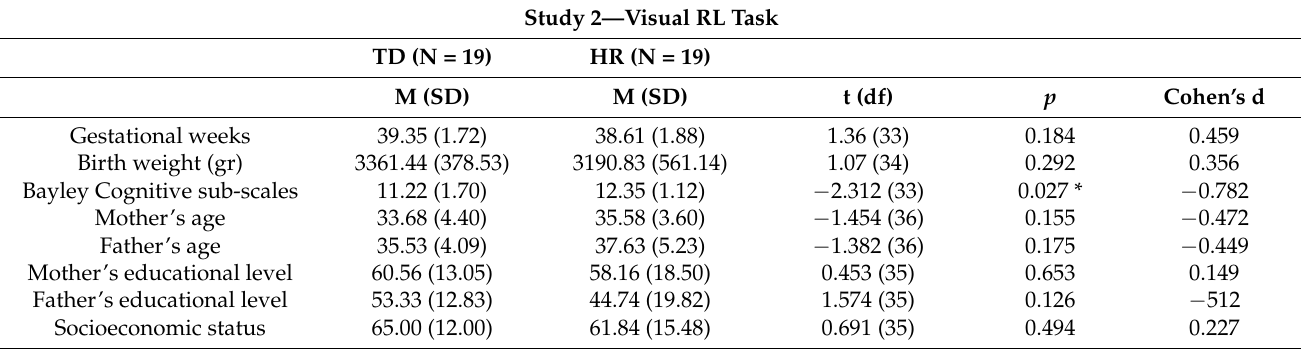
Table 3. Descriptive statistics (mean and standard deviation) of demographic characteristics for the TD and the HR